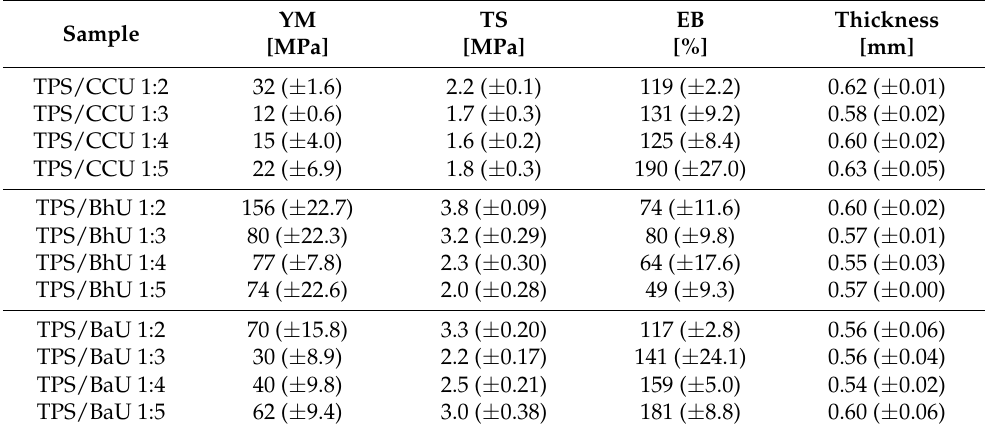
Table 2. Mechanical properties of TPS films obtained via thermocompression directly from the premixture (test 1) plasticized with U-based eutectics (YM—Young’s modulus, TS—tensile strength, EB—elongation at break).